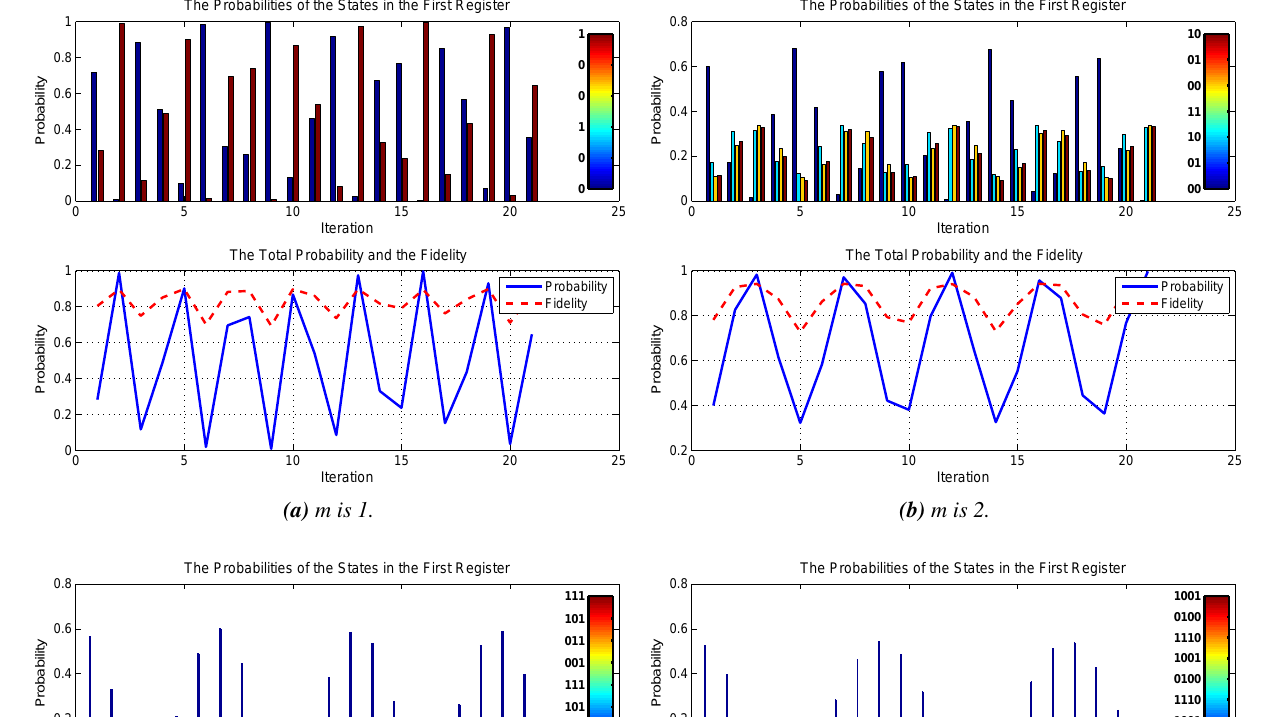
(f) m is 6. Figure 4: The probability changes in the iteration of the amplitude amplification for a random 2 7 × 2 7 matrix with 2 7 / 2 number of zero eigenvalues and a random input | x (cid:105) (MATLAB code for the random generation is given in Appendix). In each subfigure, we have used di ff erent numbers of qubits, m, for the first register to see the e ff ect on the results. The bar graphs in the subfigures shows the probability change for each state | j (cid:105) , j = 0 . . . 1 , of the first qubit. For each state, a di ff erent color tone is used.